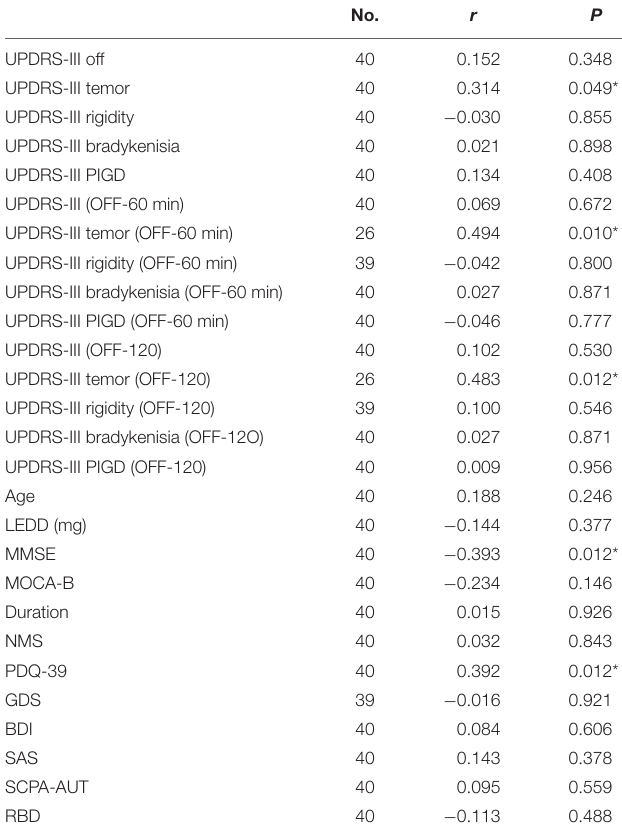
TABLE 2 | Correlations with PDQ-39